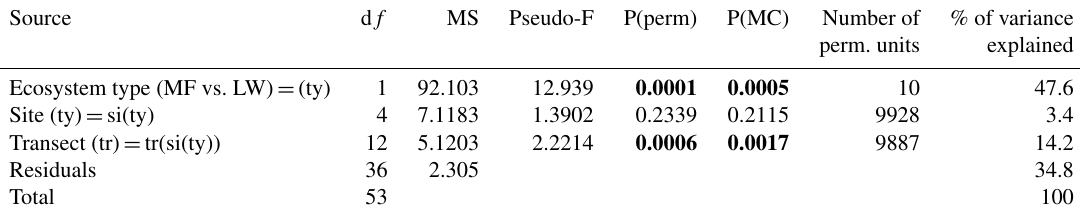
Table 5. Results of PERMANOVA on the ecosystem types and geochemical variables (MF vs. LW). Significant effects are indicated in bold. P(MC): p values obtained through Monte Carlo methods.